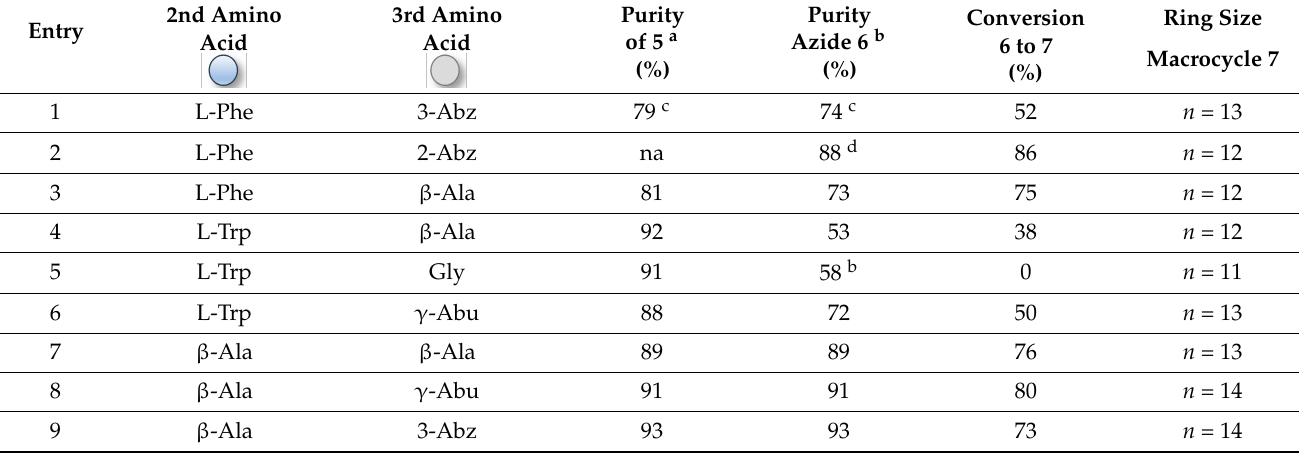
Table 3. Overview of the macrocycle syntheses on-DNA (Scheme